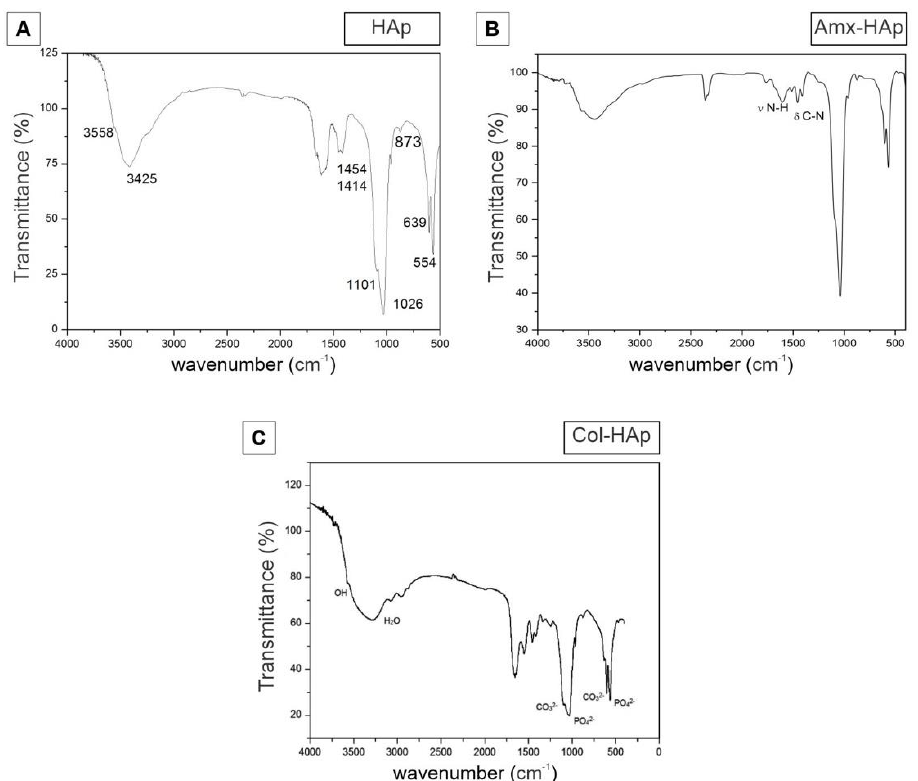
Figure 3. Characterization of HAp-based materials by FTIR spectra: ( A ) HAps, hydroxyapatite nanosheet-assembled microspheres; ( B ) Amx–HAp: amoxicillin–hydroxyapatite composite; ( C )